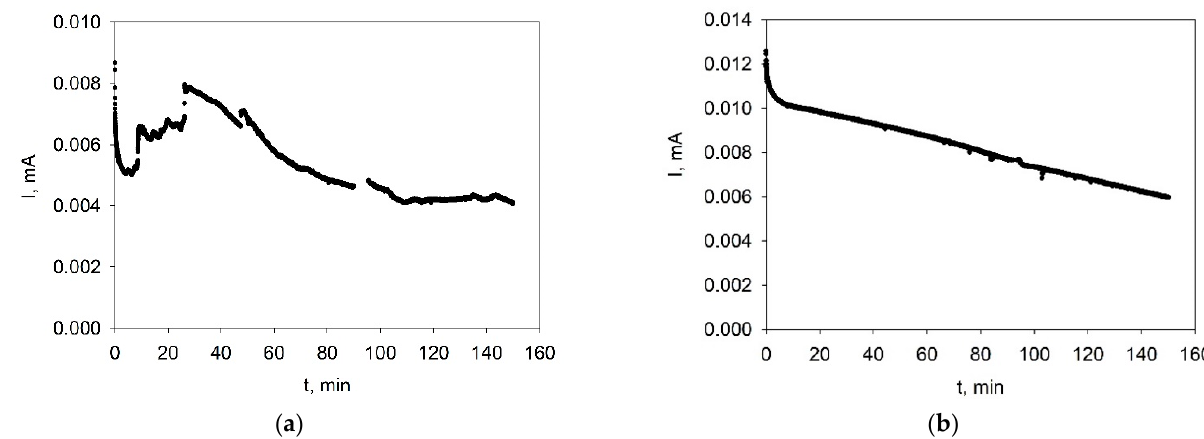
Figure 5. Time dependences of current at a constant electric field of 20 V/cm for ( a ) vertical and ( b ) horizontal EPD from YLO_i_1 suspension.